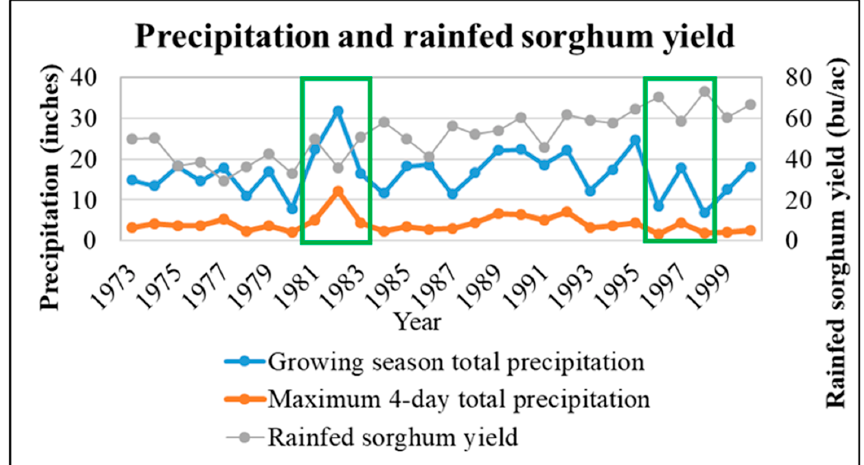
Figure 10. Graph showing rainfed sorghum yield, maximum 4-day total precipitation, and growing season total precipitation for Hunt County.